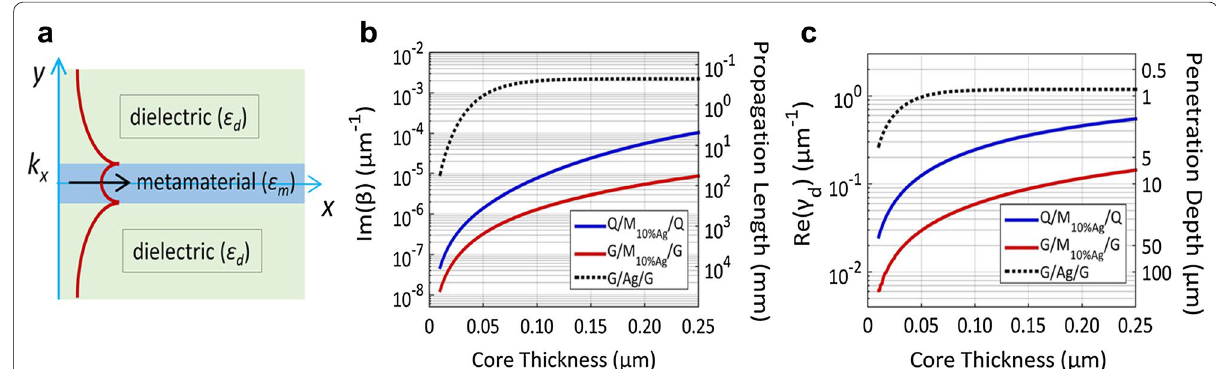
Fig. 7 A three-layer (dielectric/metamaterial/dielectric) waveguide structure. a Schematic of surface-bound wave supported by a three-layer waveguide: Ag/SiO 2 -based hyperbolic metamaterial core (with f Ag b Analytical calculation of propagation length for core thickness in the range of 10–250 nm. c Analytical calculation of penetration depth into